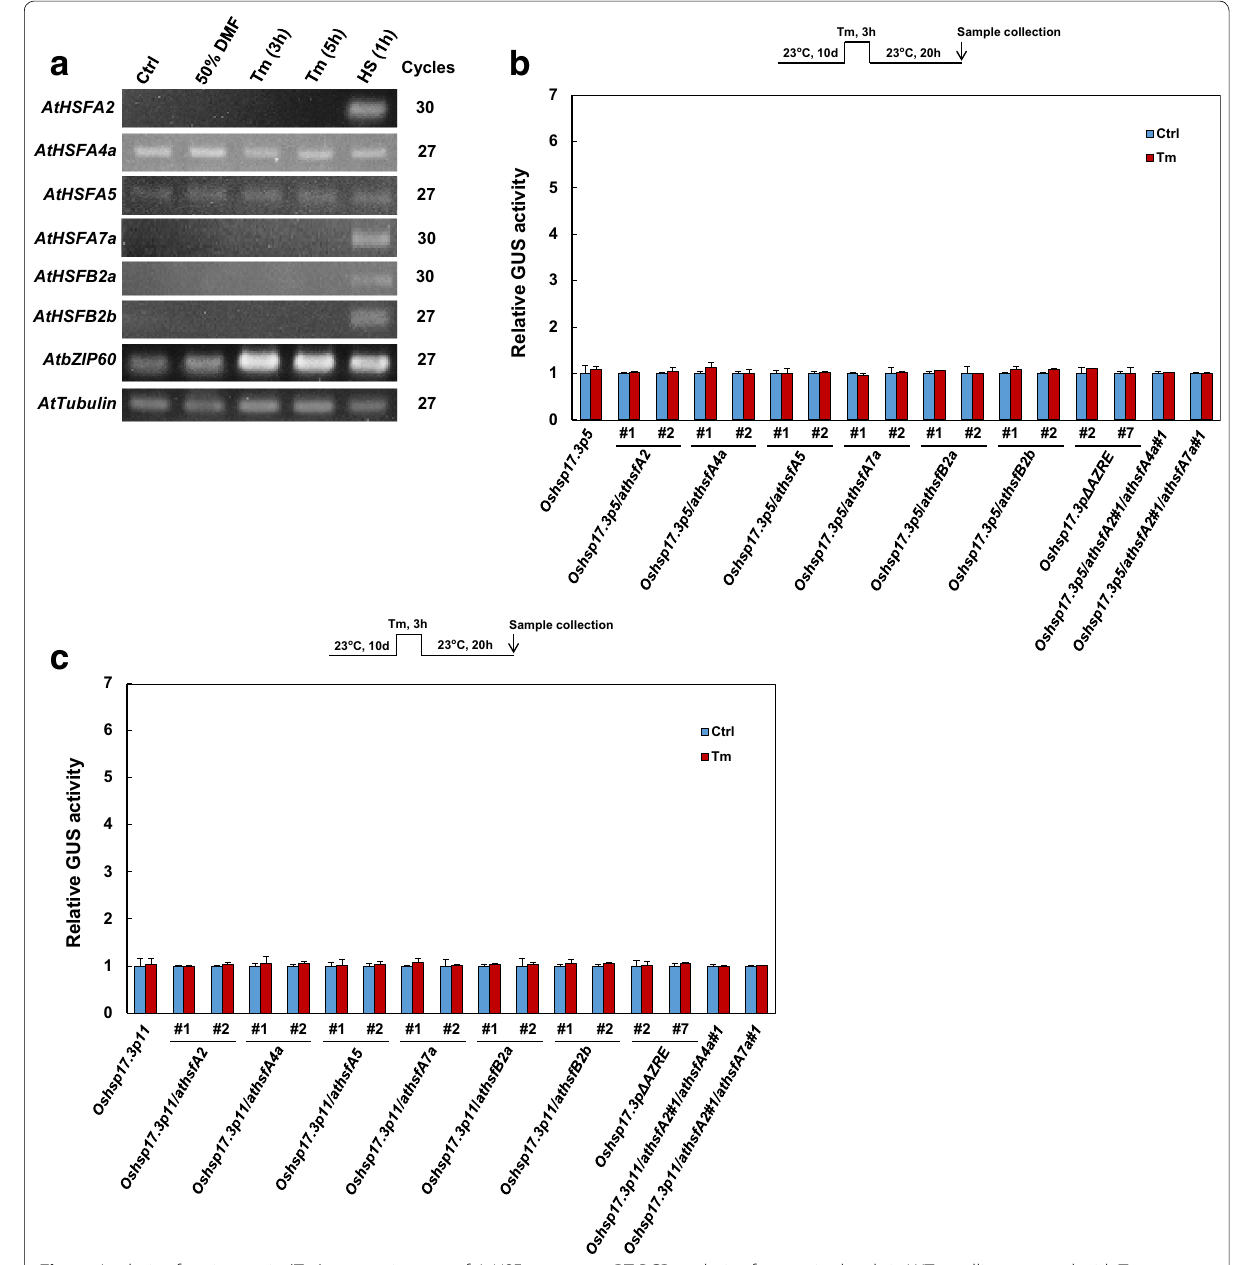
Fig. 4 Analysis of tunicamycin (Tm) responsiveness of AtHSF mutants. a RT‑PCR analysis of transcript levels in WT seedlings treated with Tm or solvent (dimethylformamide; DMF) and HS for the indicated times. mRNA expression of AtbZIP60 was a positive control for HS and Tm treatment. AtTubulin level was an internal control. Two biological repeats were performed, and similar results were obtained. b , c Relative GUS activity of seed‑ lings treated with Tm. Data are mean SE GUS activity relative to that of non‑stress control condition (Ctrl) from three independent ±